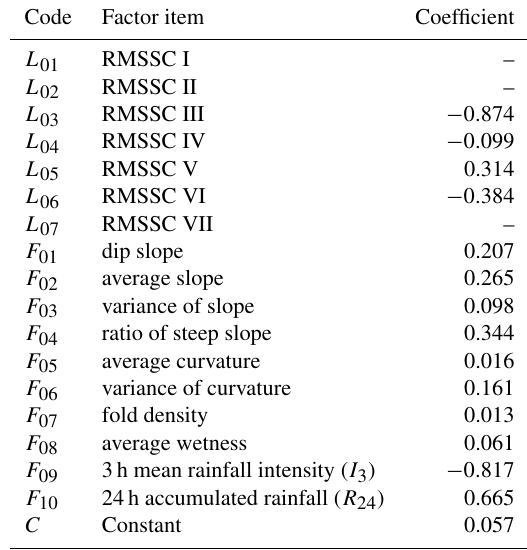
Table 2. Predisposing factors and their coefficient in logistic regres- sion